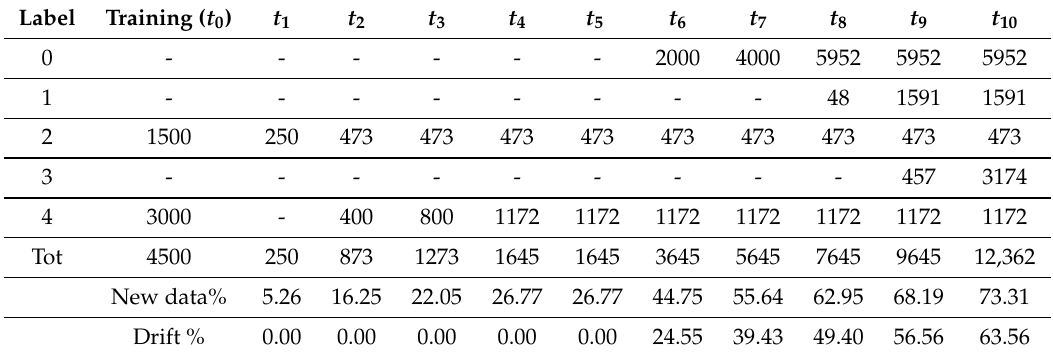
Table 4. Self-assessment service, data injection